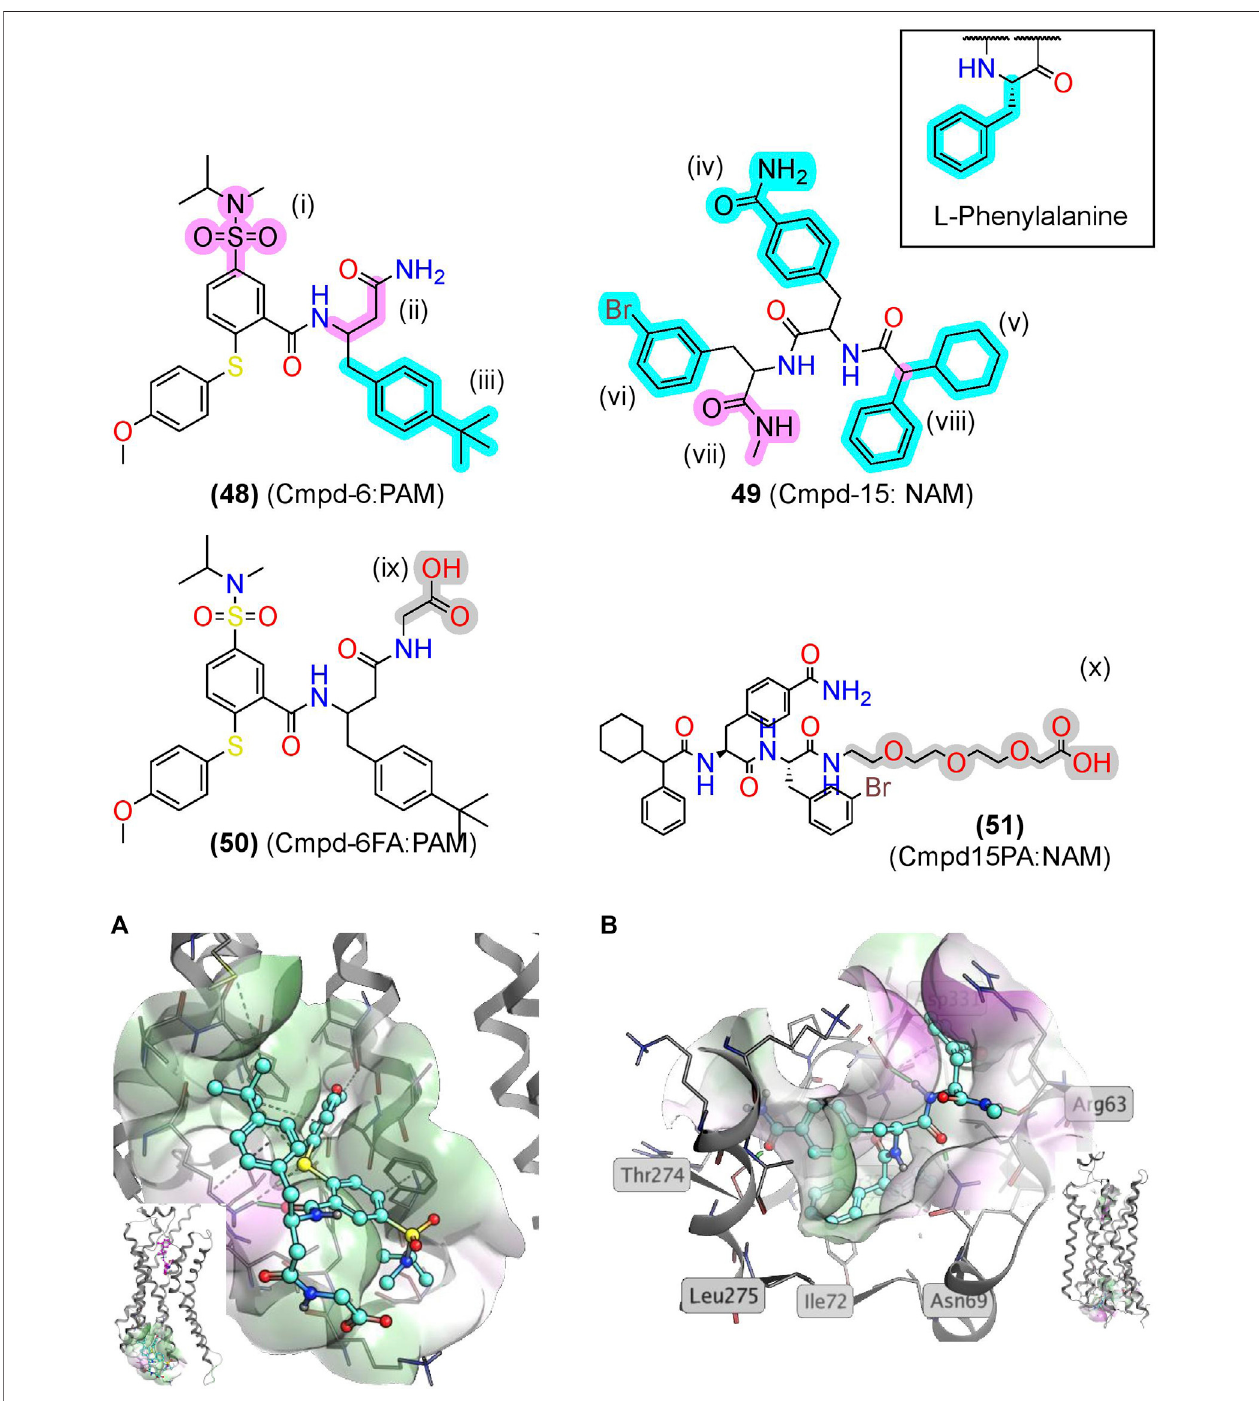
FIGURE10| β AR2AMs identi fi ed from exogenoussynthetic libraries arepolyamideswith peptidomimetic-likefeatures. (A) The β 2ARcocrystallizedwith thePAM, Cmpd-6,boundtoanintracellularbindingpocket[PDBCode:6N48(Liuetal.,2019)].( Inset )Sideviewwithorthostericligandshowninpink. (B) The β 2ARcocrystallized with the NAM, Cmpd-15, bound at an intracellular [PDB Code: 5X7D (Liu et al., 2017)]. ( Inset ) Side view with orthosteric ligand was shown in pink. Amide isosteres and backbonemodi fi cationsarehighlightedinpink;sidechainisostereswerehighlightedincyan.VanderWaalssurfacewasshowninsemitransparentsurface(green (cid:1) lipophilic;purple (cid:1) hydrophilic).Thein-textcompoundnumber isbold,followedbyoriginalname:activity. Structures wereoriginallyreportedby Ahnetal.,2017andAhn et al., 2018. Figure was created with Chemdraw20.0 Marvin Sketch 5 and MOE. 2